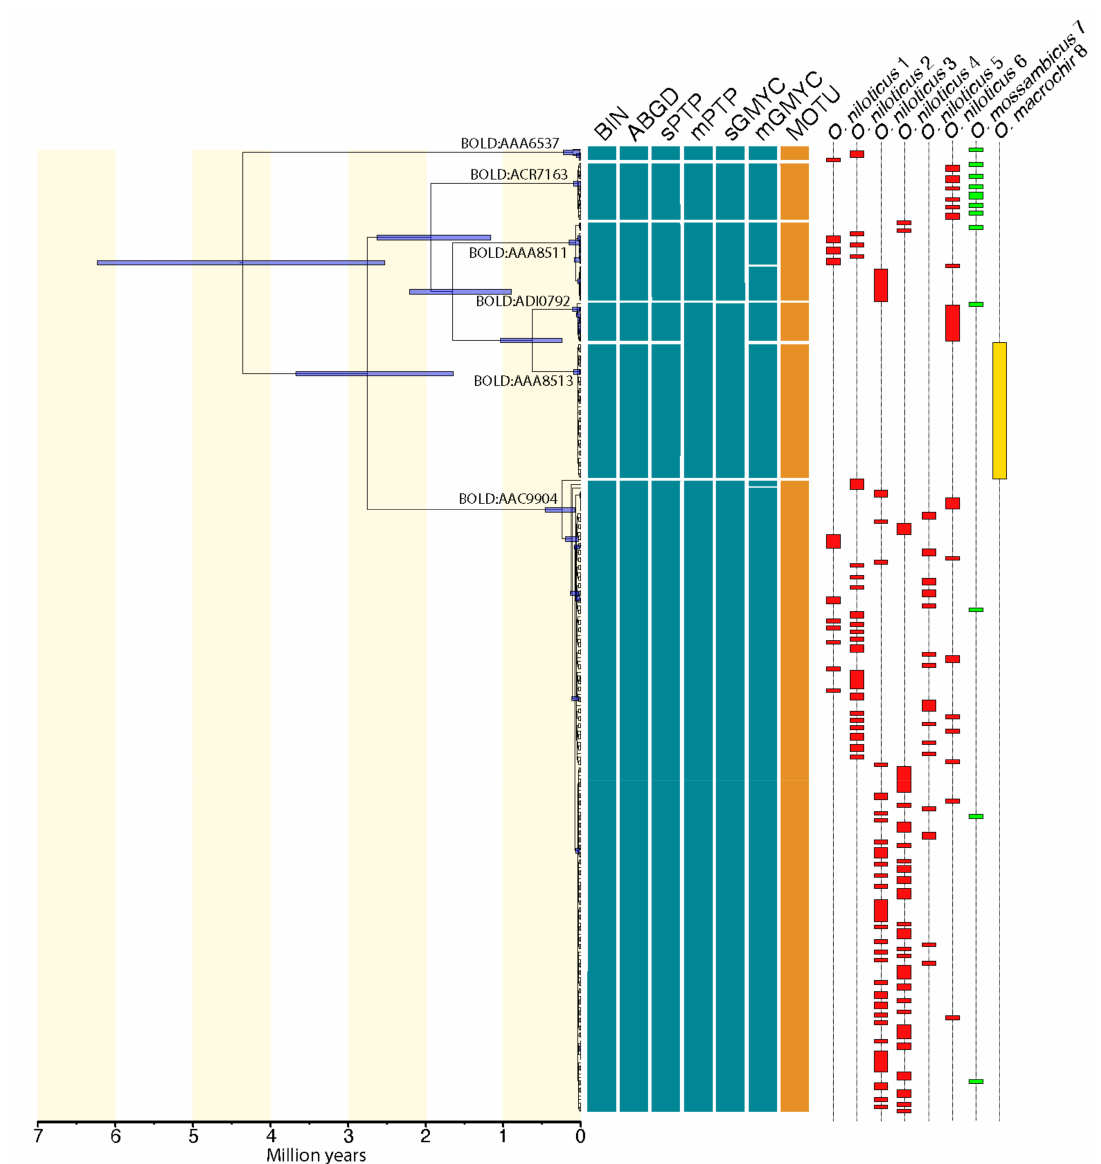
Figure 2. Mitochondrial gene tree for the 262 DNA barcodes of Oreochromis spp. inferred with SpeciesTreeUCLN, including 95% HPD interval for node age estimates, genetic lineage delimitation results for five methods (mGMYC discarded) and their 50% consensus, BOLD Barcode Index Numbers (BIN) for each MOTU, and distribution of farmed strain